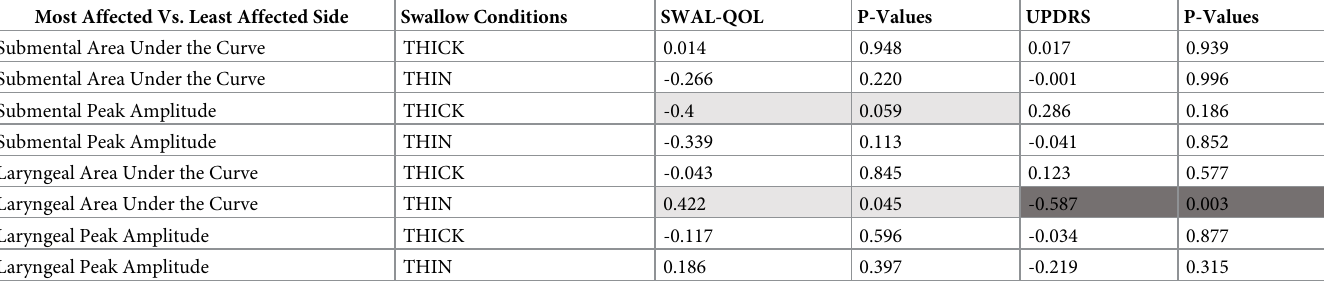
Table 3. Statistical results for associations between EMG outcome measures, UPDRS scores, and SWAL-QOL scores. Most Affected Vs. Least Affected